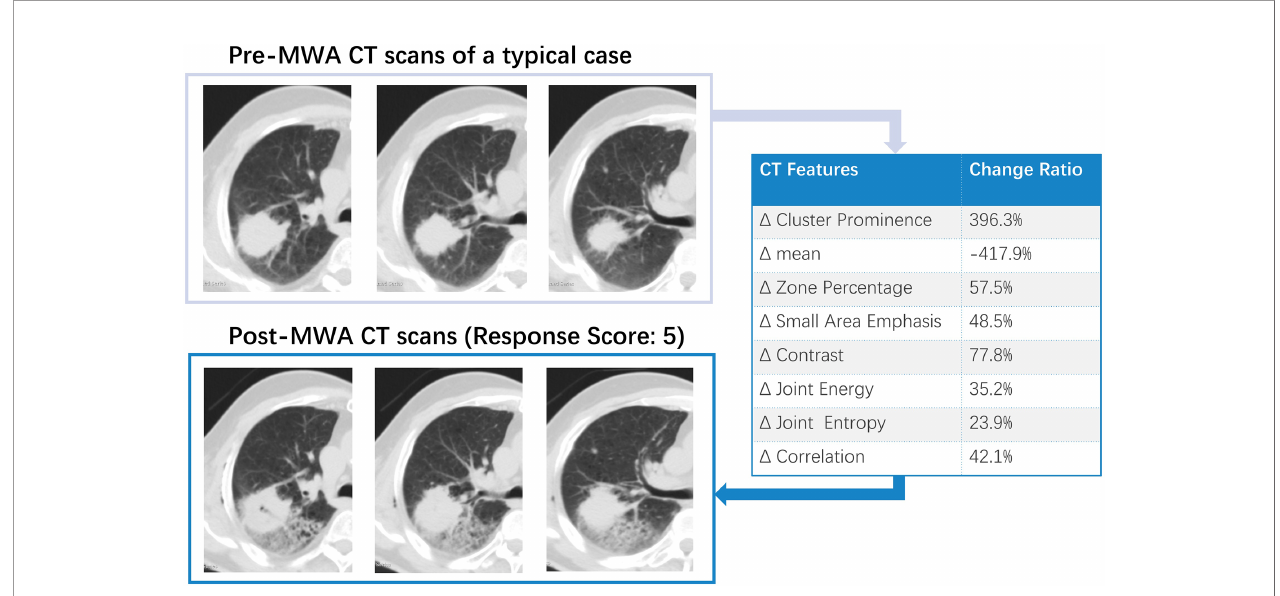
FIGURE 1 | A typical example of intra-tumoral tissue density features ’ change in CT image for patient with complete ablation. Pre-and Post-MWA image showed high repeatability. The subsequent effect of registration error was largely avoided in the data analysis.